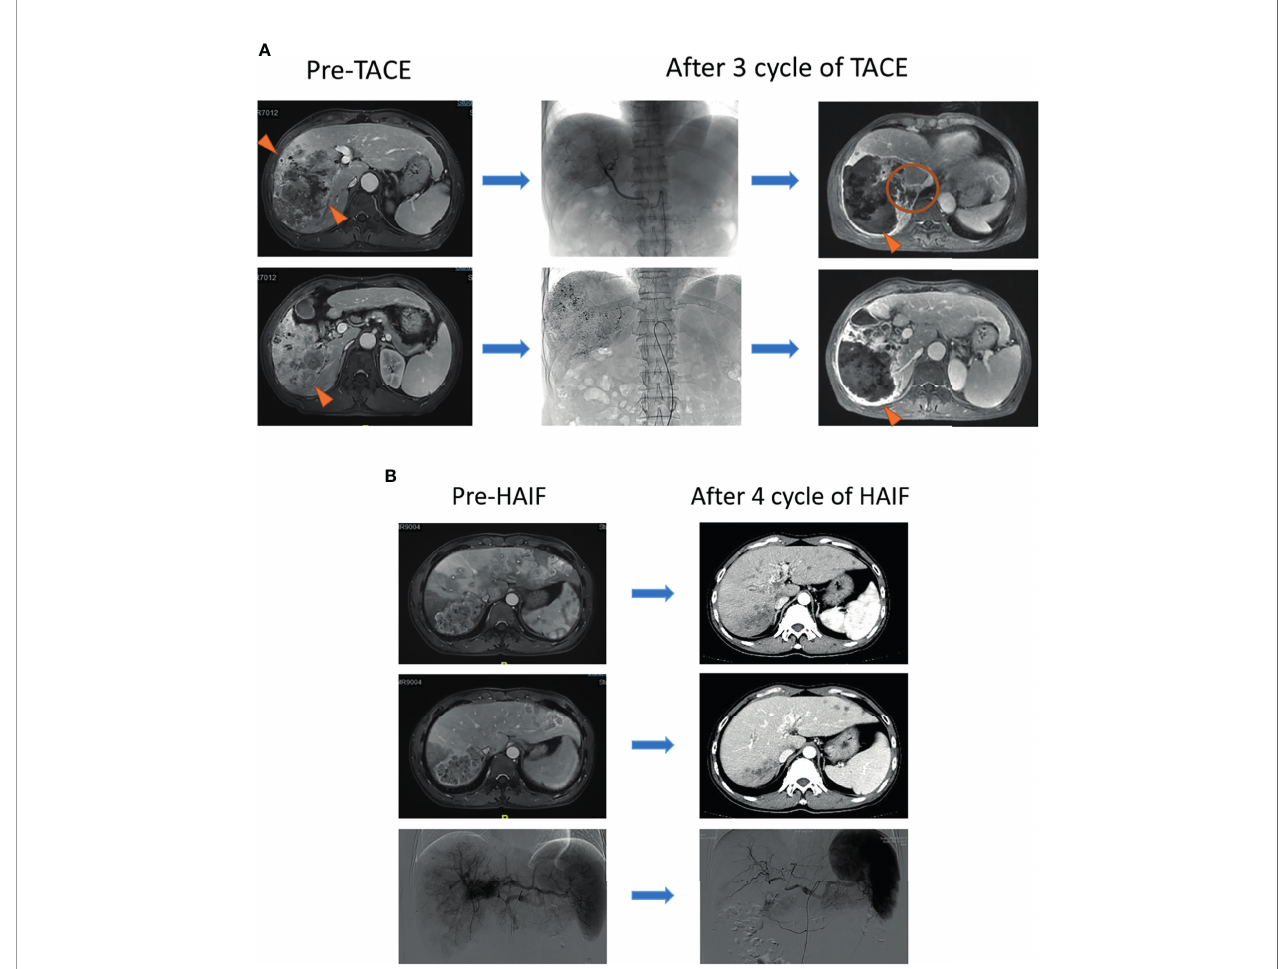
FIGURE 2 | (A) A 57-year-old male patient was diagnosed with in fi ltrative HCC by contrast MRI scanning and received three-cycle TACE. Obvious necrosis appeared in the center of the tumor after therapy (triangle), but the marginal lesions became enlarged homogeneously (circle). (B) A 46-year-old male patient with multiple lesions was diagnosed with in fi ltrative HCC. Portal vein fi stula was revealed at the arterial phase of the MRI scanning image. After a four-cycle HAIC, all of the lesions in the liver apparently shrank Table 1 . Standardized mean differences in the pre-match cohort showed signi fi cant differences in HBV, tumor number, vascular invasion, metastasis, prothrombin time (PT), and international normalized ratio (INR). After PSM adjustment, all variables achieved adequate balance. As of January 31, 2021, the study population ’ s median follow-up duration was 21.2